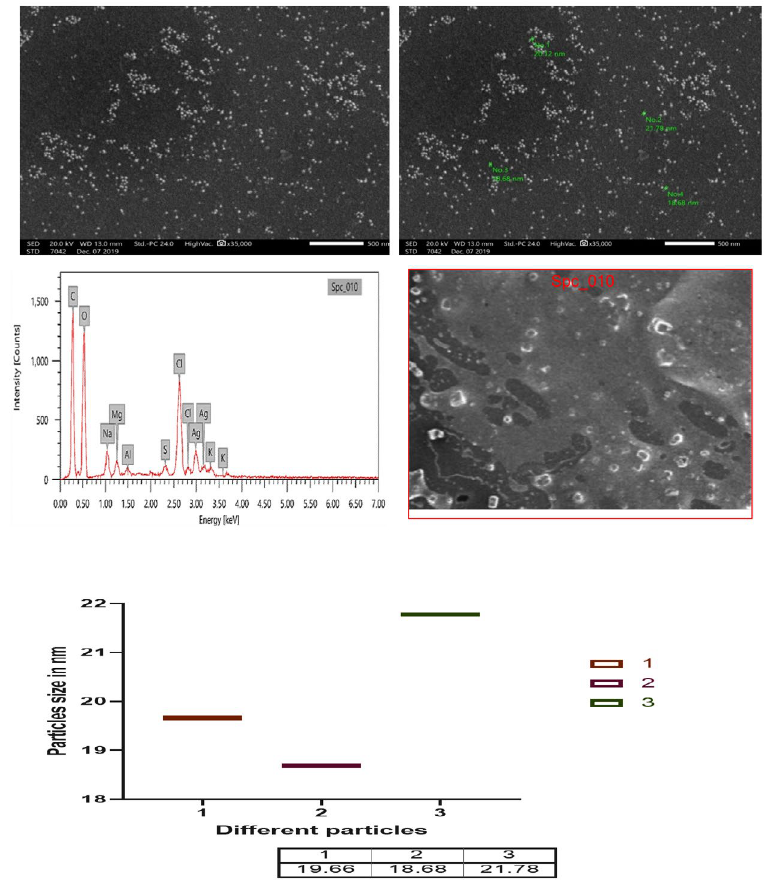
Fig. 13. SEM and EDX micrograph of the Ag-NPs produced with the Bacillus maritimus using nutrient broth